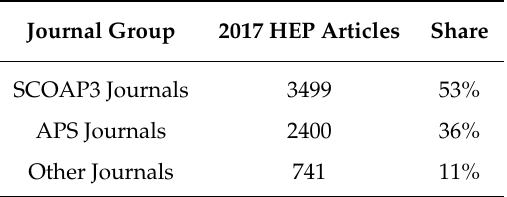
Table 2. 2017 High Energy Physics (HEP) articles by journal